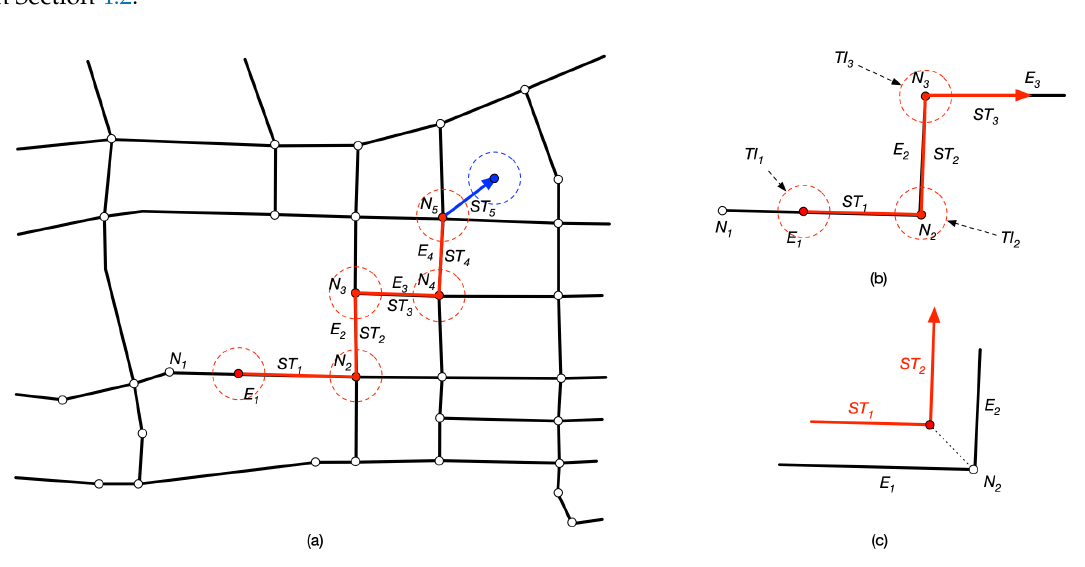
Figure 2. Trajectory-element intersections during a topological semantic trajectory. ( a ) A trajectory divided be intersections; ( b ) three detailed trajectory-element intersections within a trajectory; ( c ) corresponding relations within a trajectory-element